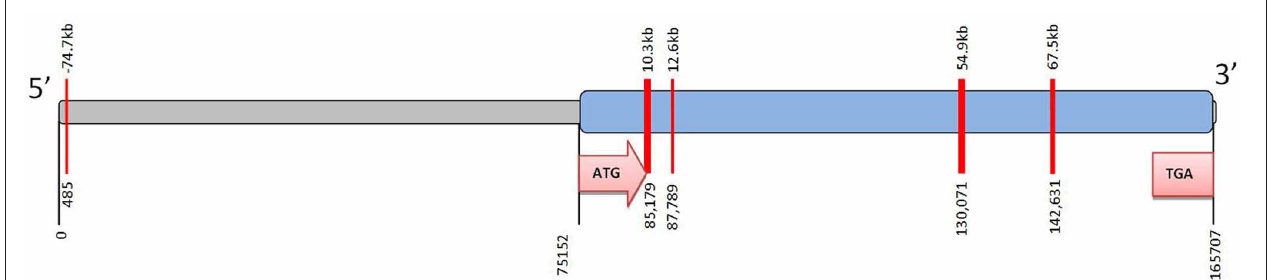
FIGURE 2 | CpG islands identified in CYP2C19. The complete CYP2C19 sequence (Ensembl Gene ID ENSG00000165841;National Centre for Biotechnology Information (NCBI); Entrez core nucleotide sequence NM 000769) was analyzed using CpG Island finder, http://cpgislands . usc . edu/ . Potential CpG island regions were determined using the following parameters %GC = 50–55%, ObsCpG/ExpCpG = 0.6, length = 100–500bp,